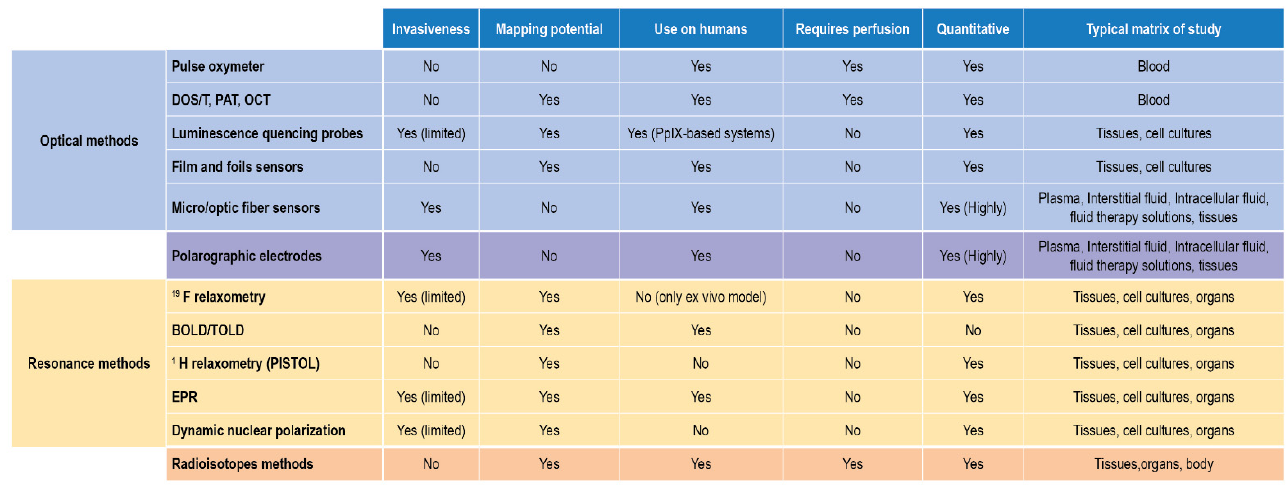
Figure 11 . DO detection methods for biological matrices and clinical settings . Figure 11. DO detection methods for biological matrices and clinical